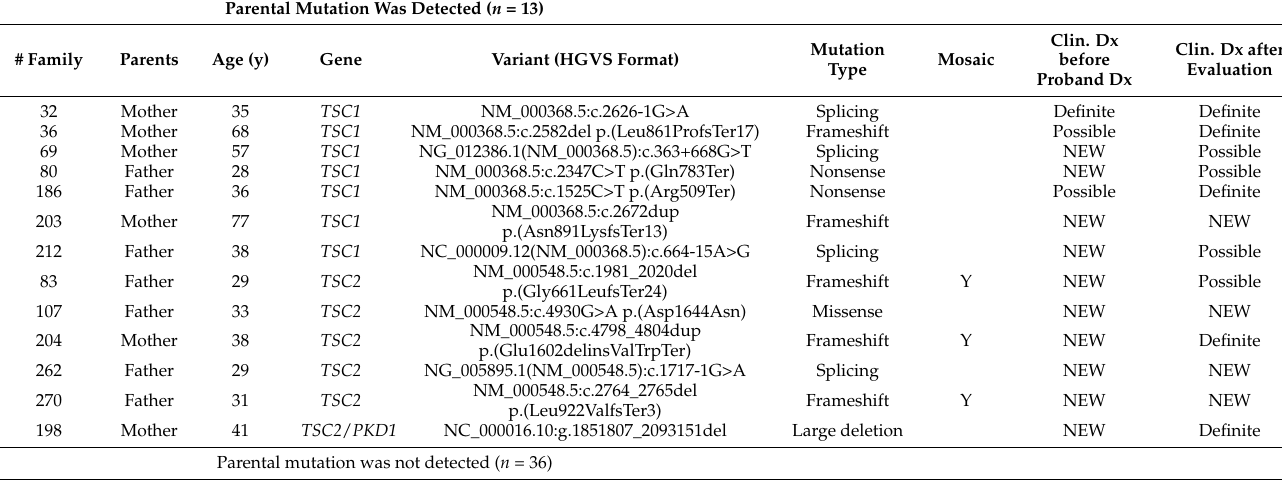
Table 10. Parental mutation